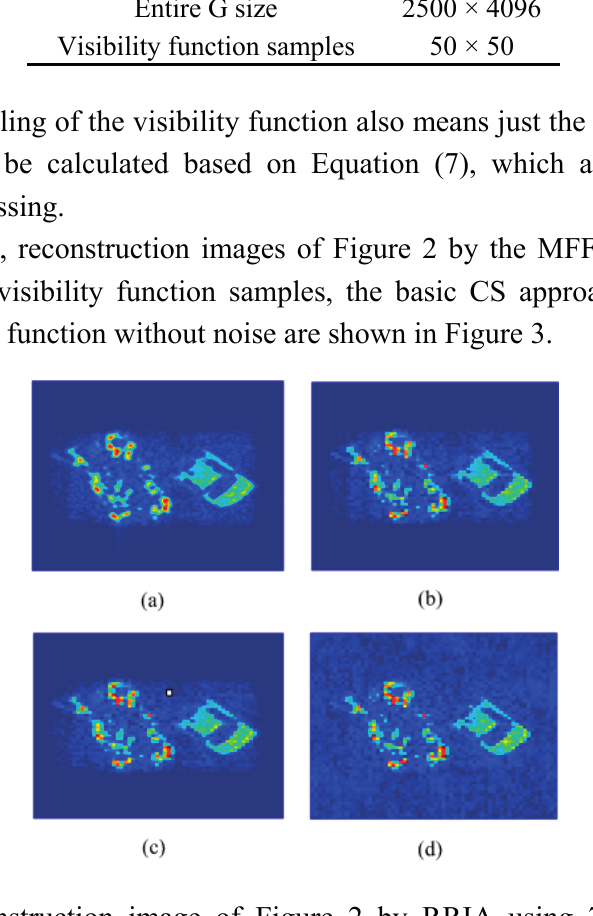
Figure 3. ( a ) Reconstruction image of Figure 2 by RRIA using 70% undersampling; ( b ) Reconstruction image of Figure 2 by CS using 70% undersampling; ( c ) Reconstruction image of Figure 2 by the G matrix inversion method; ( d ) Reconstruction image of Figure 2 by